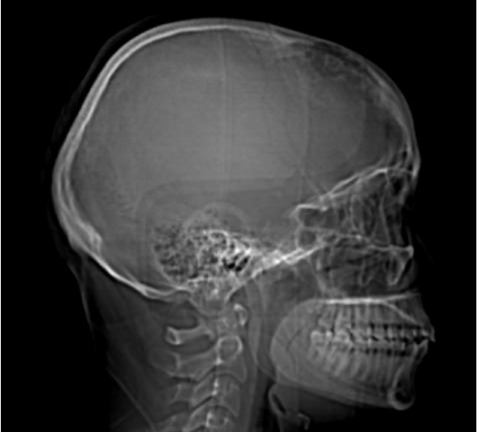
Figure 1. Skull radiography—lateral view. Erosion of the inner table of the frontal